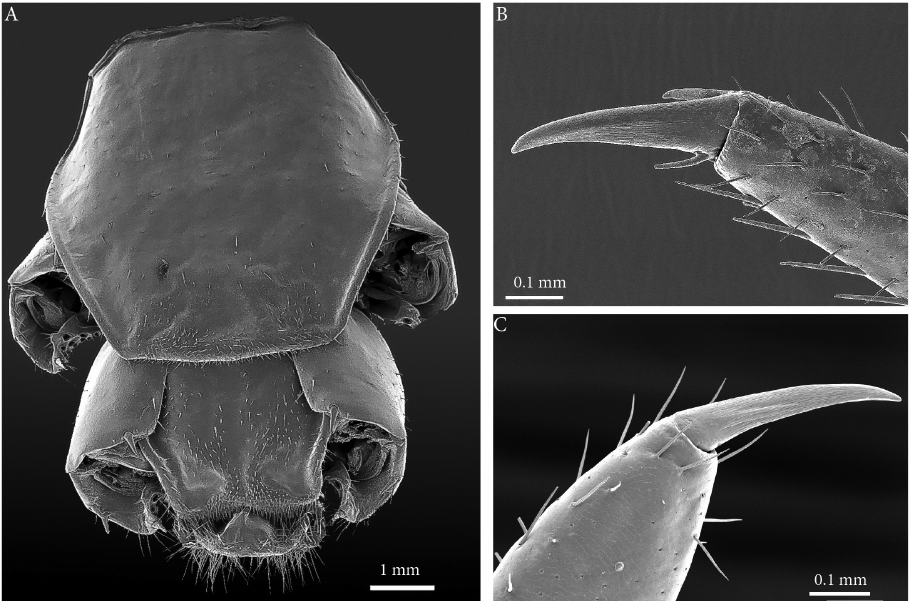
Figure 4. Eupolybothrus liburnicus sp. n., male paratype ZMUC 00040237, last tergites and pretarsi of leg 10 and 15. A T14 and intermediate tergite, dorsal view B Pretarsus of leg 10, dorsolateral view C Pretarsus of leg 15, lateral